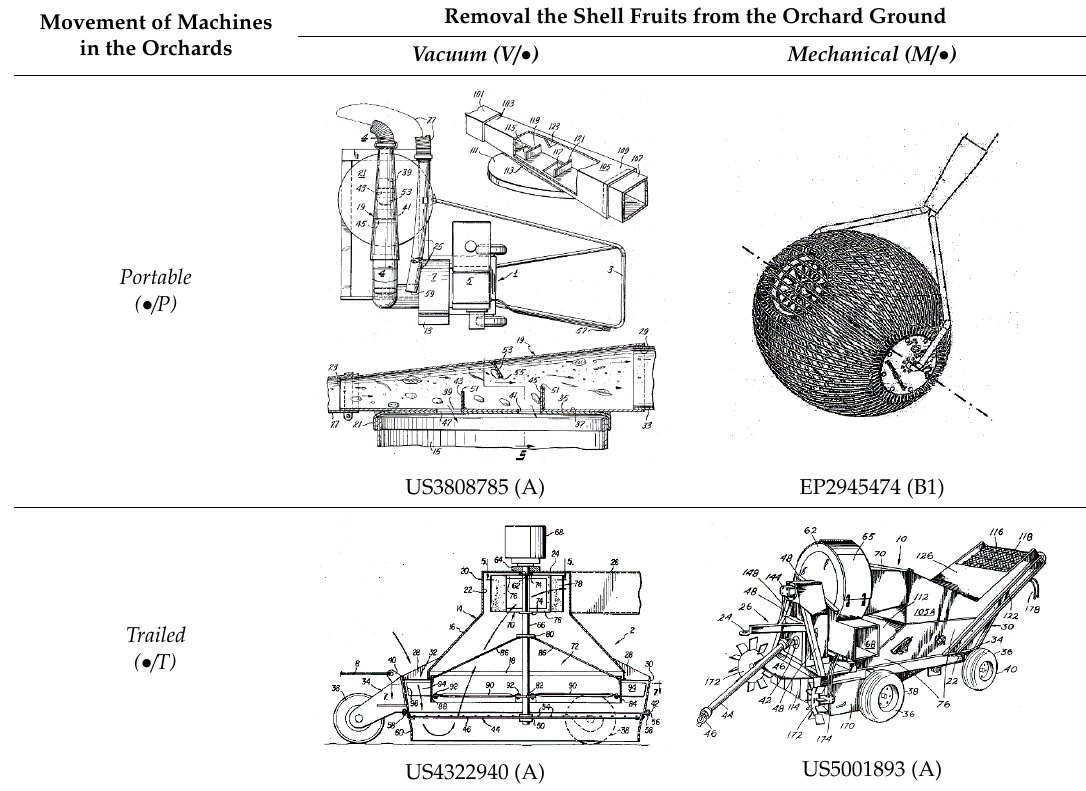
Table 1. Visual illustration of the eight categories of harvesting machines for shell fruits based on the two indicated functioning principles as classification keys.